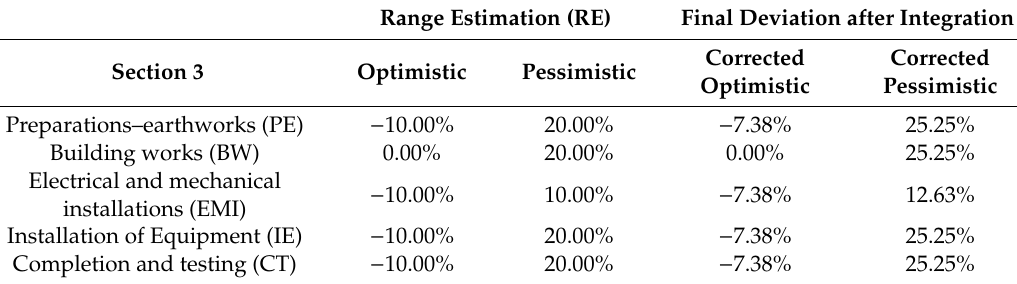
Table 6. The expert’s answers to questions of Section